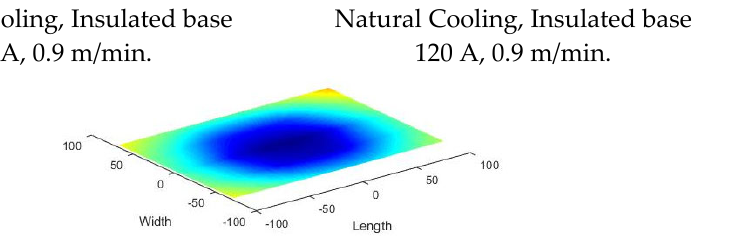
Figure 10. Range of residual stresses measured.